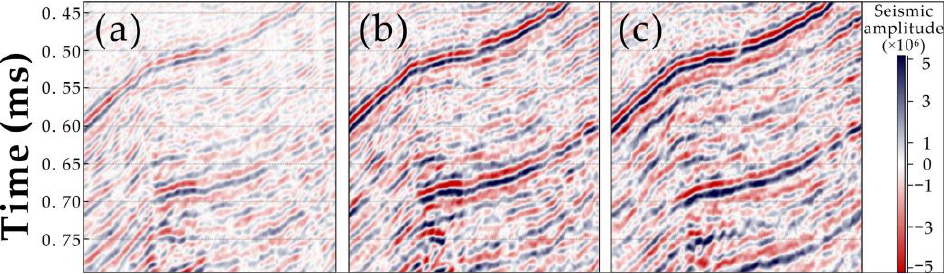
Figure 10. Partial overlay of angle data (( a ) Partial overlay of angle 1 − 12°, ( b ) Partial overlay of angle 12 − 24°, ( c ) Partial overlay of angle 24 − 35°).